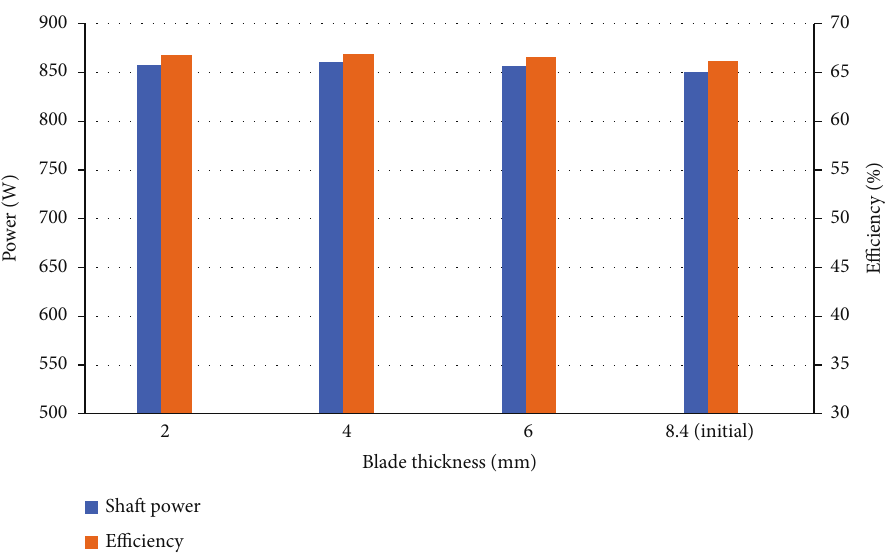
Figure 8: The e ff ect of decreasing blade thickness on the power output and e ffi ciency.